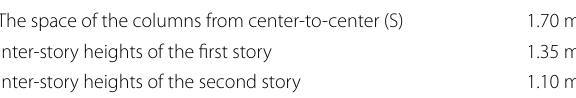
Table 1 The geometric characterization of the test specimens.